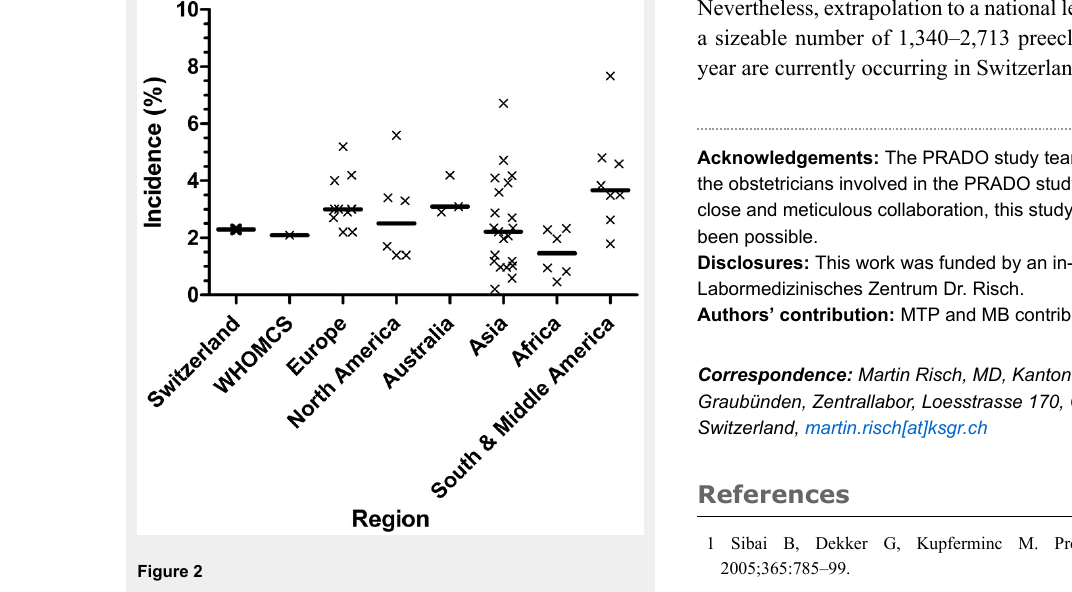
Observed incidence of preeclampsia in the Swiss PRADO study compared with worldwide and regional incidences. X denotes a point incidence observed at a specific period of time in a specific country. A bold horizontal line indicates the median of all observed incidences within a regional group. Data are taken from references [18, 26, 27, 33, 43–57] and are specified in more detail in table 3. Summary data from WHOMCS (World Health Organization Multicountry Survey on Maternal and Newborn Health) originate from reference